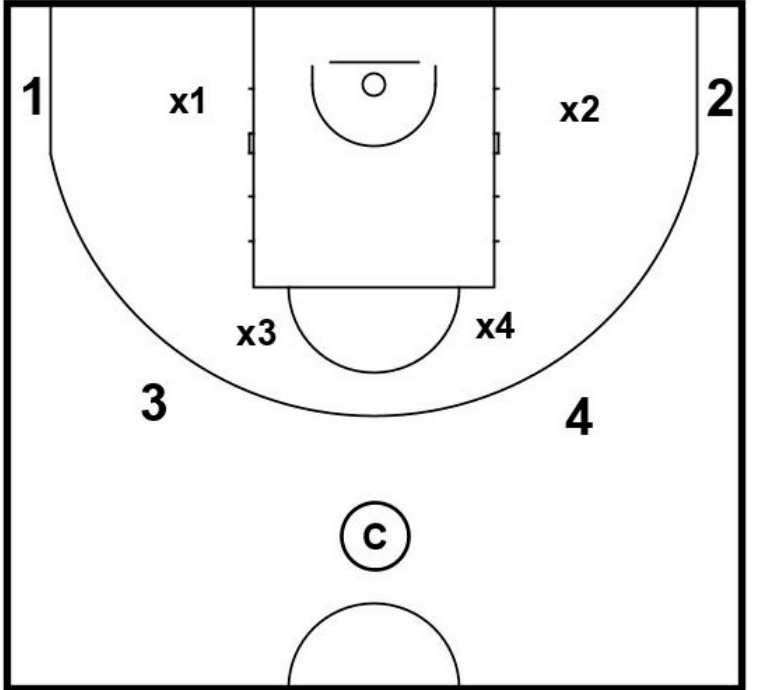
Figure 1. Initial setup of the players in the video scenes of the decision-making assessment. Note. Camera (C); Offensive players (1, 2, 3, 4); Defensive players (x1, x2, x3, x4). Numbers are not related to playing positions.